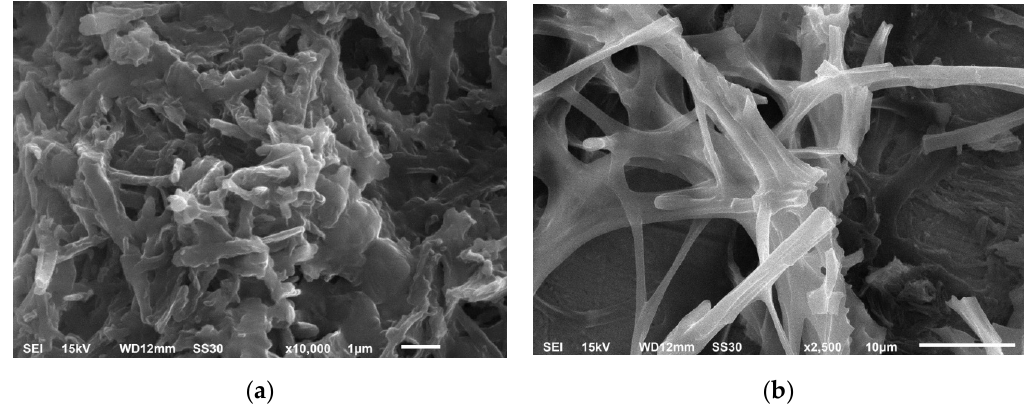
Figure 1. Microorganisms immobilized in TEG, ( a ) fungal cultures with bacteria in thermally expanded graphite; ( b ) predominance of fungal cultures in thermally expanded graphite.